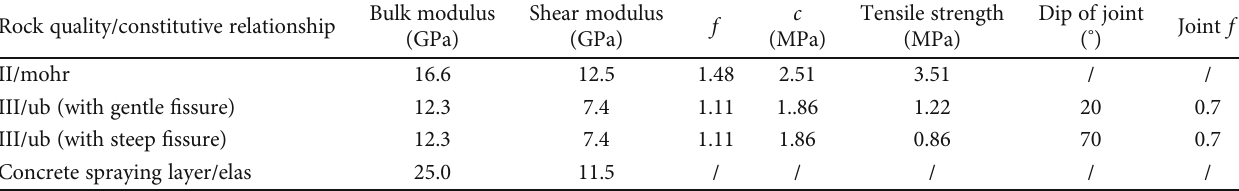
Table 2: Physical and mechanical parameters of surrounding rock and concrete shotcrete. Rock quality/constitutive relationship